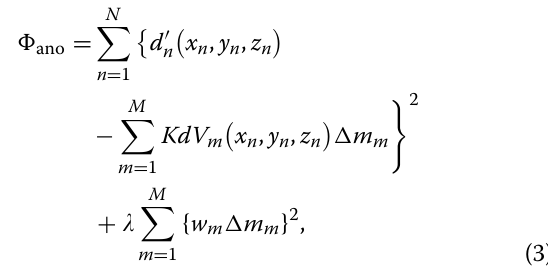
Additional file 1: Figure S1. Deviation of model parameters of magneti- zation intensity model in Fig. 3, which is represented by a square root of each diagonal element of the estimated model covariance matrix by the ABIC minimization. Additional file 2: Figure S2. (a) ABIC with a hyperparameter λ depend- ency. A closed circle is a minimum point of ABIC. (b) Data misfit